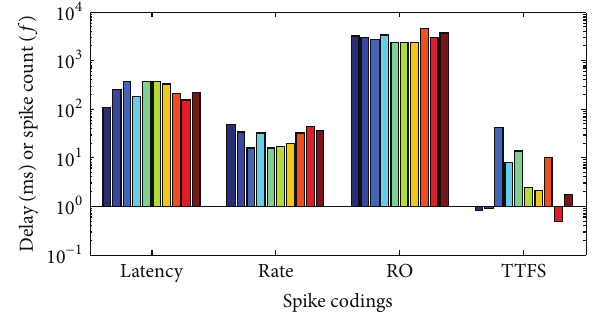
Figure 7: Detailed description on the classification model, showing different spike interpretations on classification of a probe patch against 10 gallery